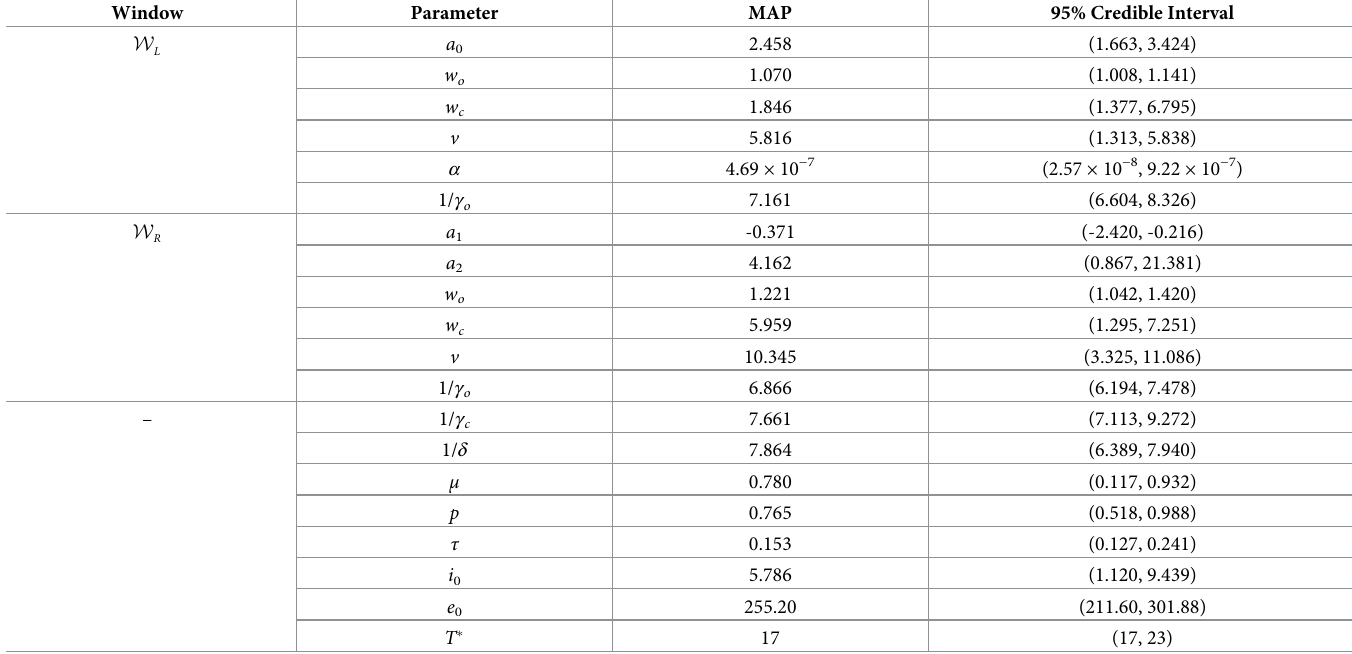
Table 2. MAP estimates and associated credible intervals for Malaysia.